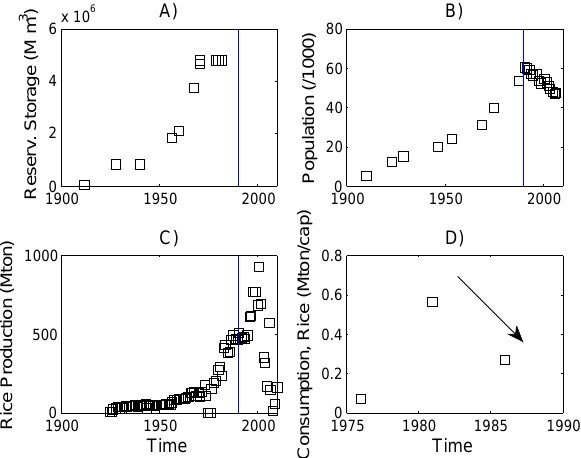
Figure 3. (a) – (c) Historic reservoir capacity, population and rice production in Murrumbidgee River basin, Australia (Kandasamy et al., 2014). The vertical lines indicate the year 1990. (d) Imputed Agricultural Income per unit labor, in units of mton/capita. Based on New South Wales censuses 1976, 1981, 1986. See the Appendix on how the values are imputed and converted into rice amounts. A decline in consumption per capita for a decade before 1990 (the year of eventual decline in Murrumbidgee population) is